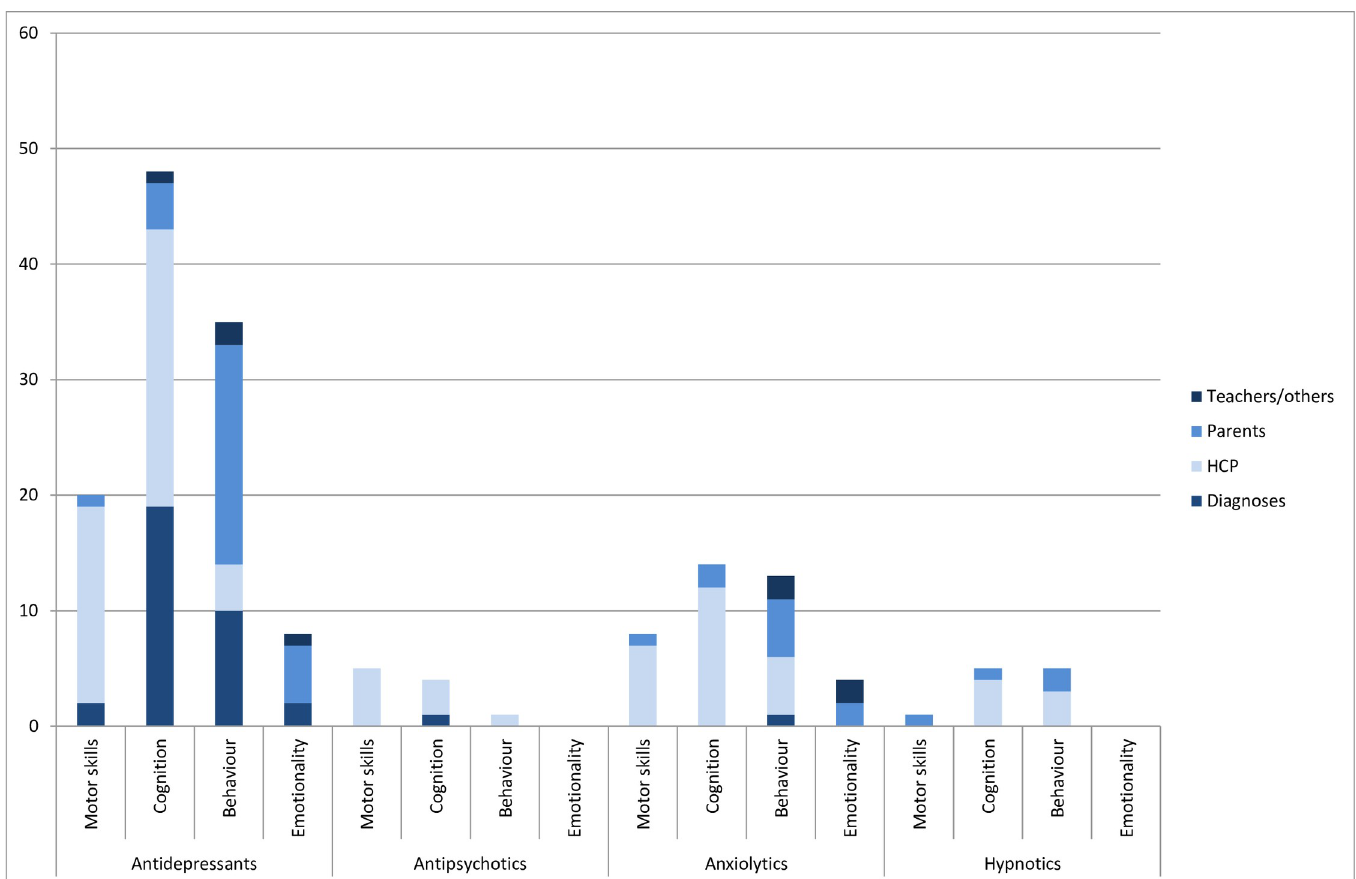
Fig 2. Domains of neurodevelopment evaluated and data sources used in medication safety papers on psychotropics. Some papers had outcomes from more than one domain and assessments from more than one type of assessor. HCP: Health care professionals.